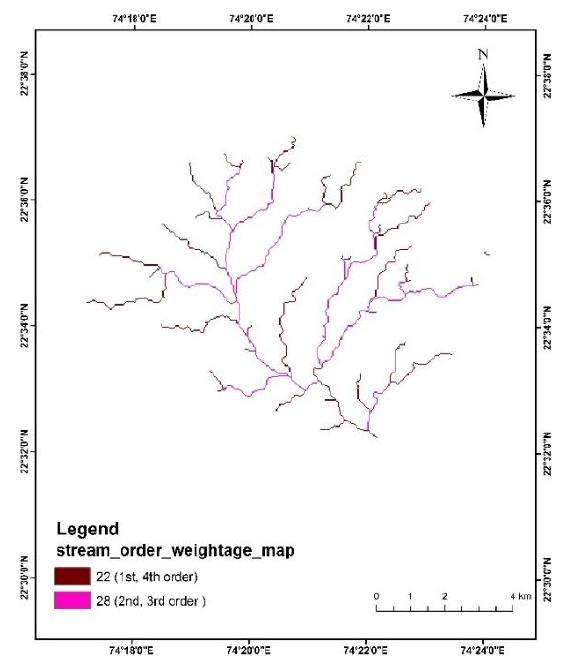
Figure 9. Stream order weightage map